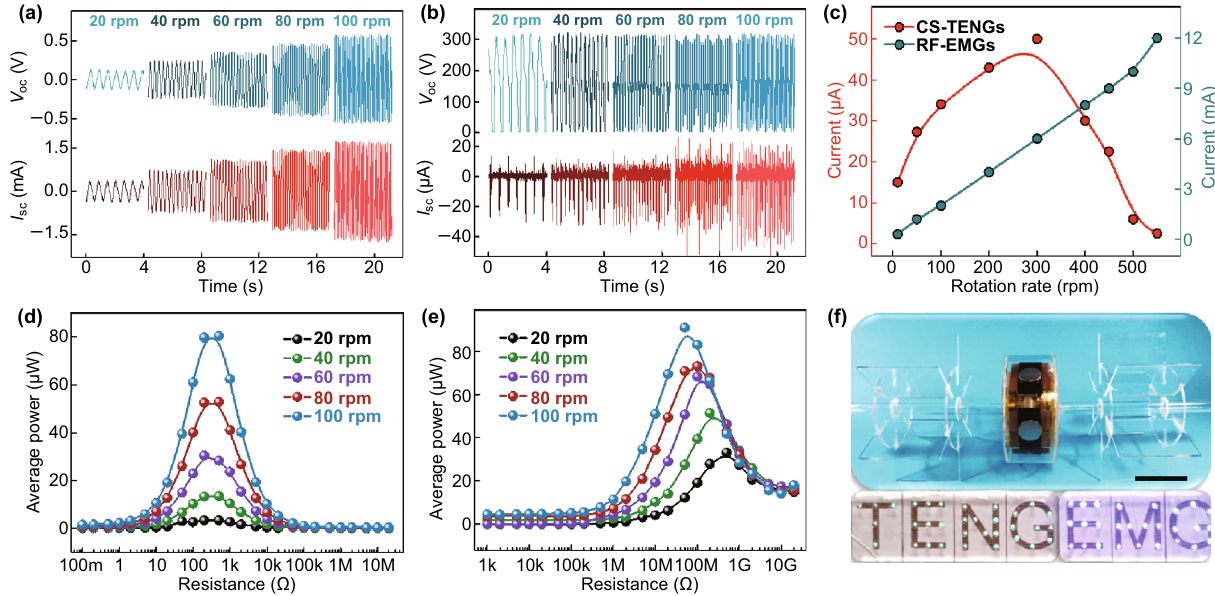
Fig. 3 Electrical output performance of each functional component of the TEHG. V oc and I sc of a five RF-EMGs connected in series and b five CS-TENGs connected in parallel at a rotation speed ranging from 20 to 100 rpm. c Dependence of the output current on the rotation rate of the TEHG. Dependence of the average power of d the RF-EMGs and e the CS-TENGs on the external load resistances. f The words ‘‘TENG’’ and ‘‘EMG’’, made up from LEDs, were lighted (scale bar: 5